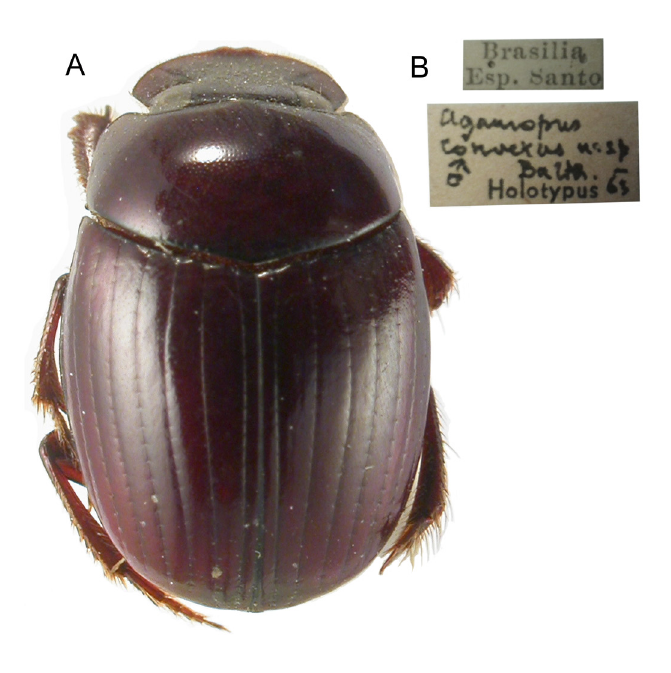
Fig. 11. Agamopus convexus Balthasar, 1965 (now Ateuchus convexus comb. nov.). Holotype (NMPC). A . Habitus, dorsal view. B . Labels. Length of specimen: 6.5 mm. Photograph: Jiří Hájek,